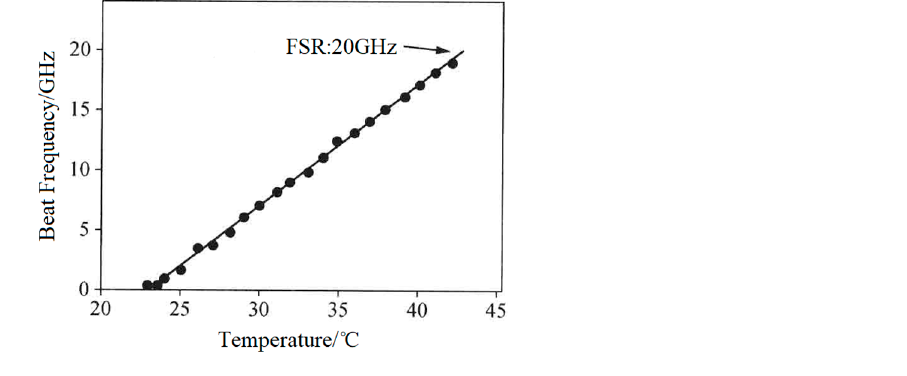
Figure 16. Dependence of frequency difference of dual-frequency laser on laser temperature [27].